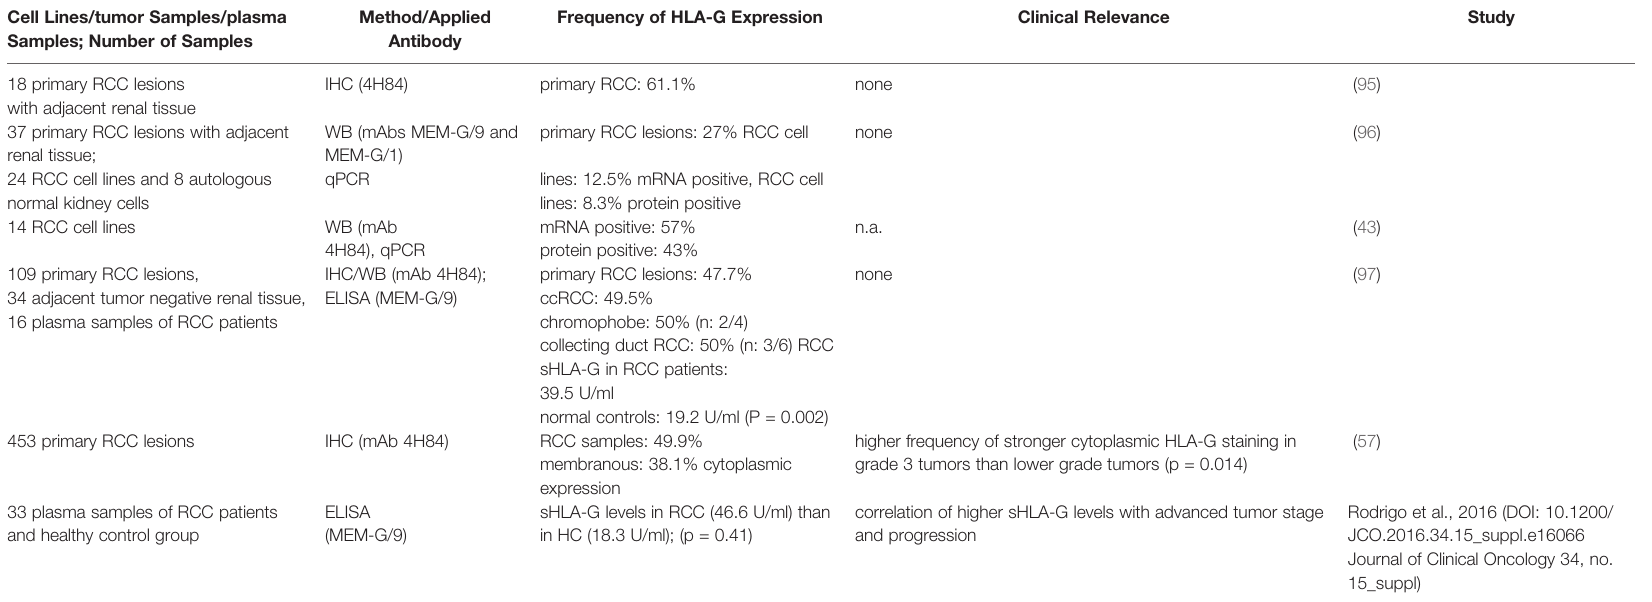
TABLE 3 | Frequency of HLA-G expression and its clinical relevance in